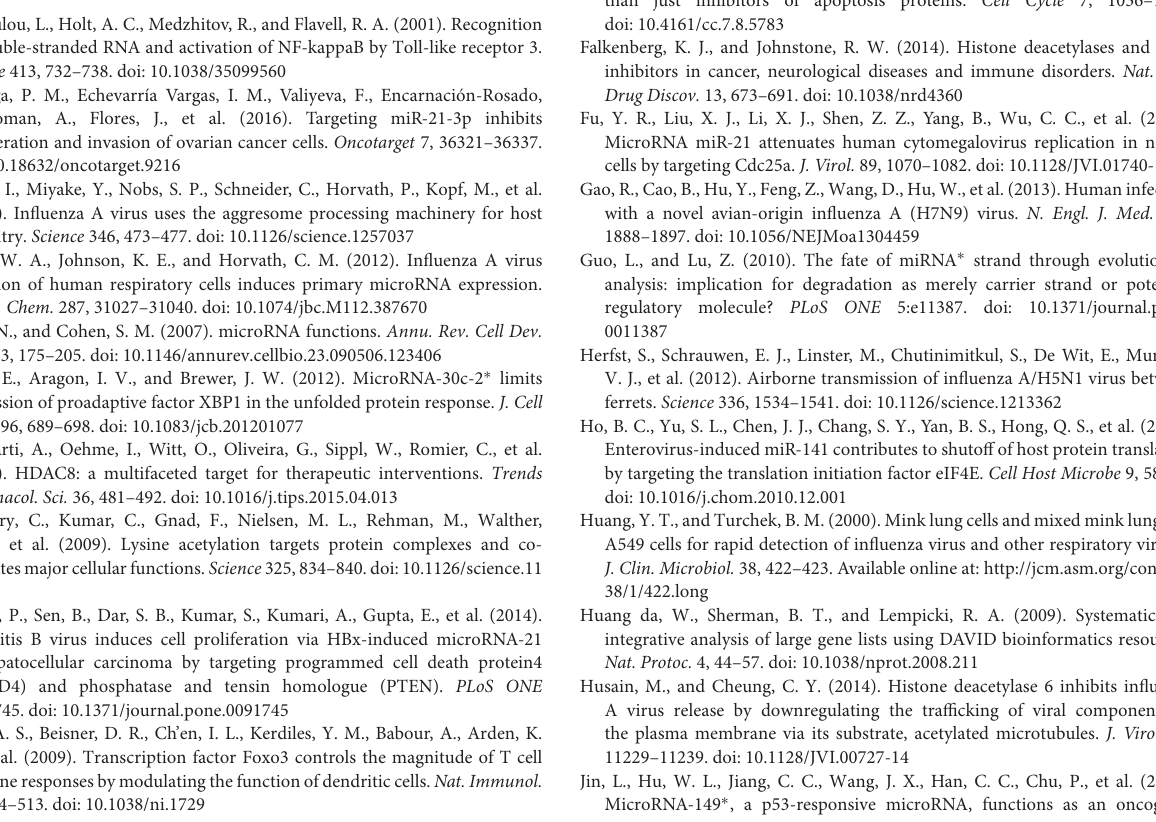
infected cells was observed at different time points by using Nikon microscope and Canon Camera. Magnification, × 20. Figure S2 | miR-21-3p relative expression in A549 cells. Total RNA was purified from A549 cells and reverse transcribed using the First-Strand cDNA Synthesis Kit with a specific stem-loop primer. The expression of miR-21-3p and miR-200c were measured by qPCR and normalized to expression of U6 snRNA. The expression of miR-200c was set to a value of 1 for normalization purposes. Data are the mean ± SD from four independent experiments. n.s., not significant, vs. miR-200c by t -test. Figure S3 | Analysis of miR-21-3p potential targets. (A–H) 293T cells were cotransfected with pRL-TK plasmid and luciferase reporter plasmids encoding the 3 ′ UTRs of candidate genes, together with negative mimic or miR-21-3p mimic. After 24h, firefly luciferase activity was measured and normalized by Renilla luciferase activity. Data are the mean ± SD from three independent experiments. ∗ P < 0.05, ∗∗ P < 0.01, and ∗∗∗ P < 0.001 vs. negative mimic by t -test. Figure S4 | HDAC8 overexpression does not affect IAV replication. (A) A549 cells were transfected with pCMV-tag2B-HDAC8 plasmid and negative control plasmid. After 24h, HDAC8 protein expression was detected by flag antibody. Data are representative of two independent experiments. (B,C) A549 cells were transfected with pCMV-tag2B-HDAC8 plasmid and negative control plasmid. Twenty-four hours after transfection, cells were infected with H1N1 or H5N1 at a MOI of 0.1. Viral NP vRNA was analyzed at 48 hpi by real-time qPCR. Data are the mean ± SD from four independent experiments. n.s., not significant, vs. negative control by t -test. Table S1 | Primers used in this study. Table S2 | (Microsoft Excel format). GO and KEGG pathway analysis of targets of dysregulated miRNAs during IAV